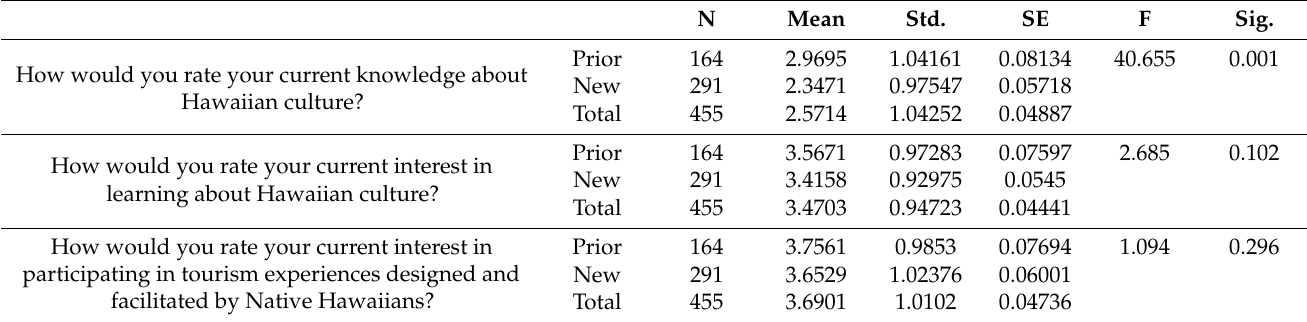
Table 2. Participants’ current knowledge of, and interest in, Hawaiian culture. N Mean Std. SE F Sig.